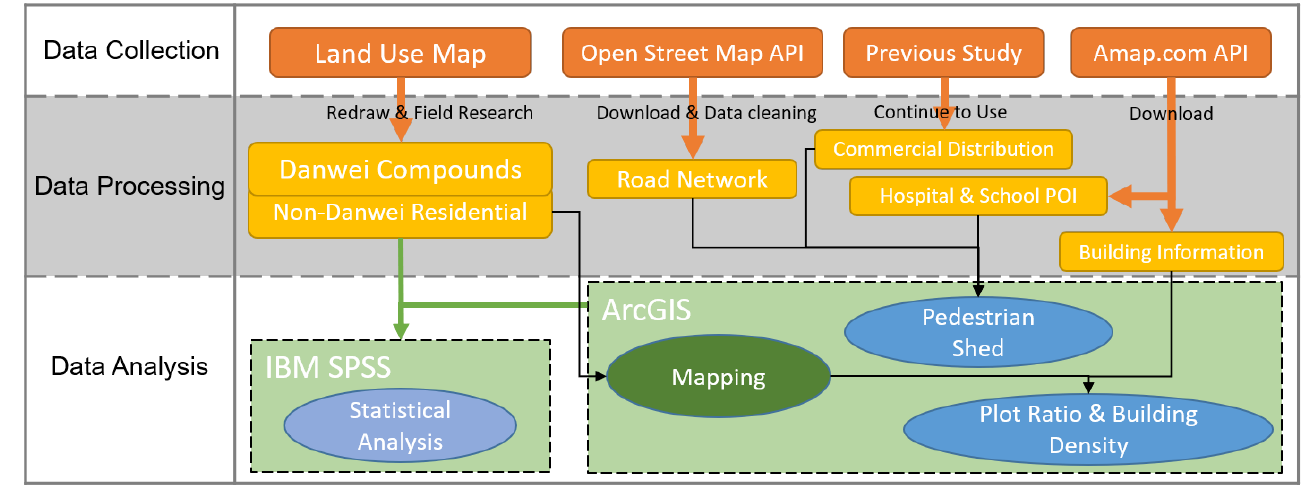
Figure 1. Study’s workflow.